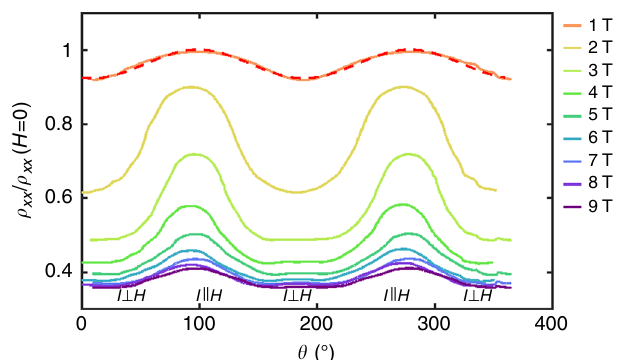
Fig. 5 In-plane anisotropic magnetoresistance. Angular dependence of the in-plane magnetoresistance showing the AMR in various magnetic fi elds. The red dashed line shows a fi t to cos 2 θ for the lowest fi